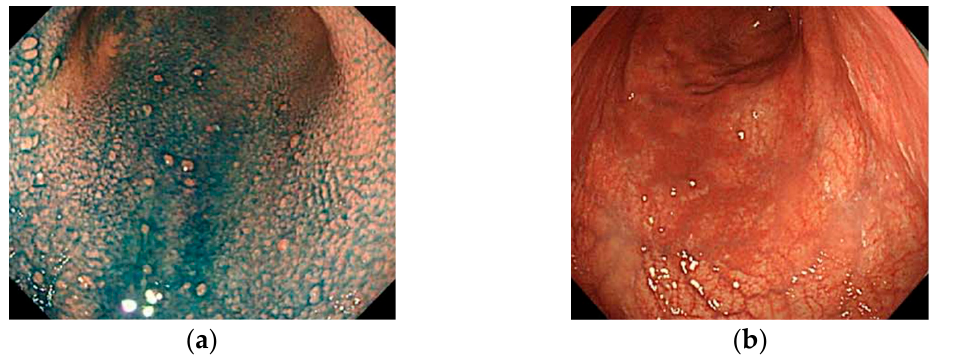
Figure 3. Images of remnants of oxyntic mucosa: ( a ) pseudopolyp ‐ like type; ( b ) extensive type.